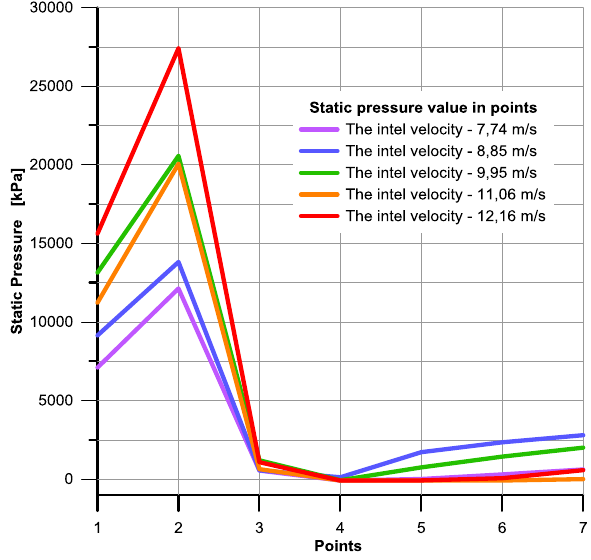
Fig. 9. The results of pressure in the tunnel for all points .